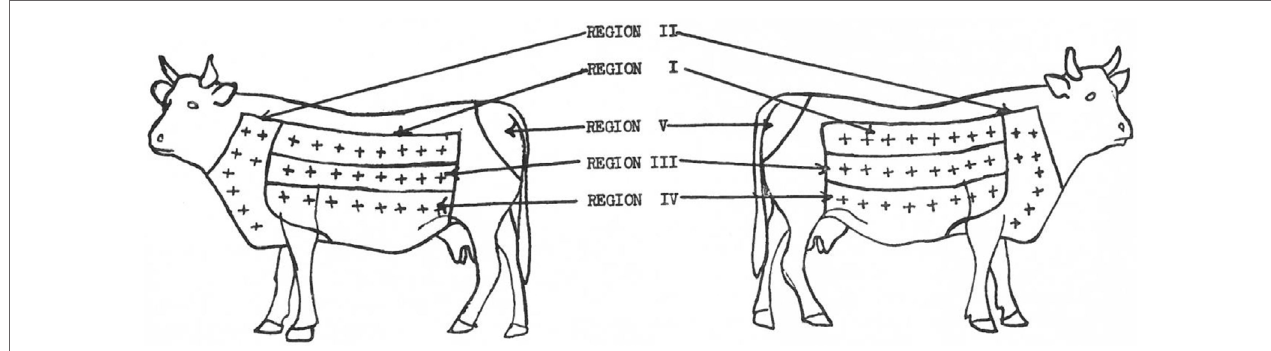
FiGuRe 1 | Location of skin regions on right and left sides of animals. Injection sites in each region = + . [Reprinted with permission of the AVMA (Am J Vet Res (1950) 11:301 – Larsen et al.